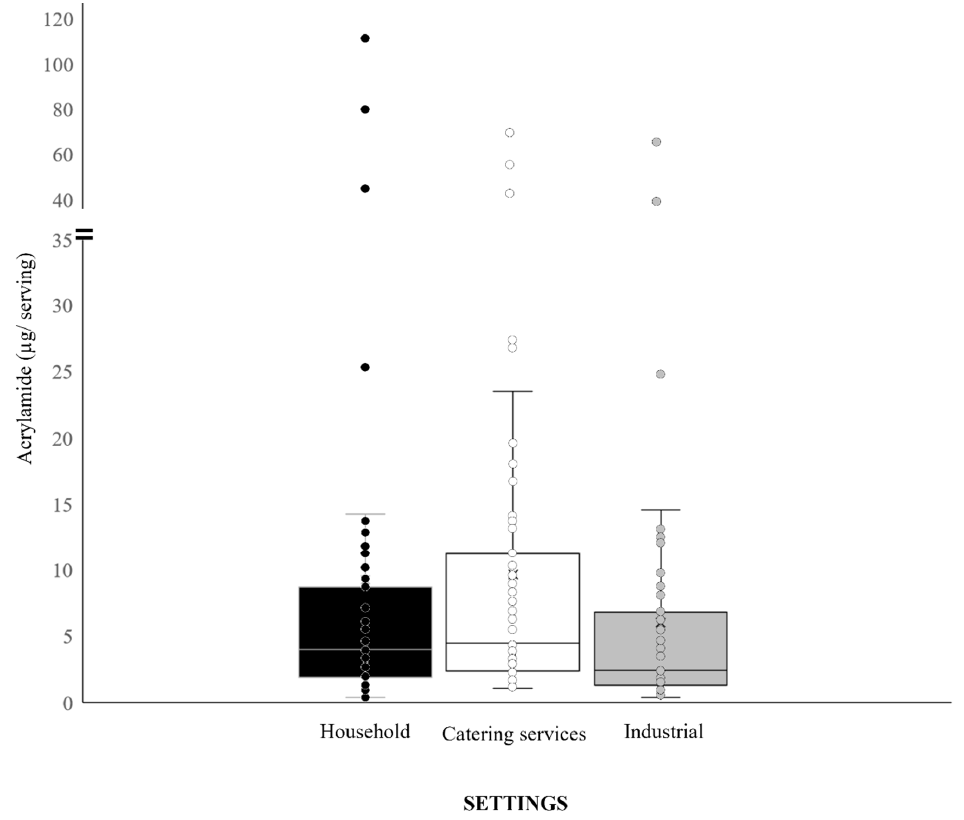
Figure 2. Distribution of acrylamide exposure (µg/serving) in the three settings (household, catering services and industrial) with each of the processed food groups analysed (chips, Spanish omelette, torrijas , sponge cake, breaded fillet, ham and cheese fillet, pizza, puff pastry pie, patties, migas , croquettes). Values are mean ± SD.